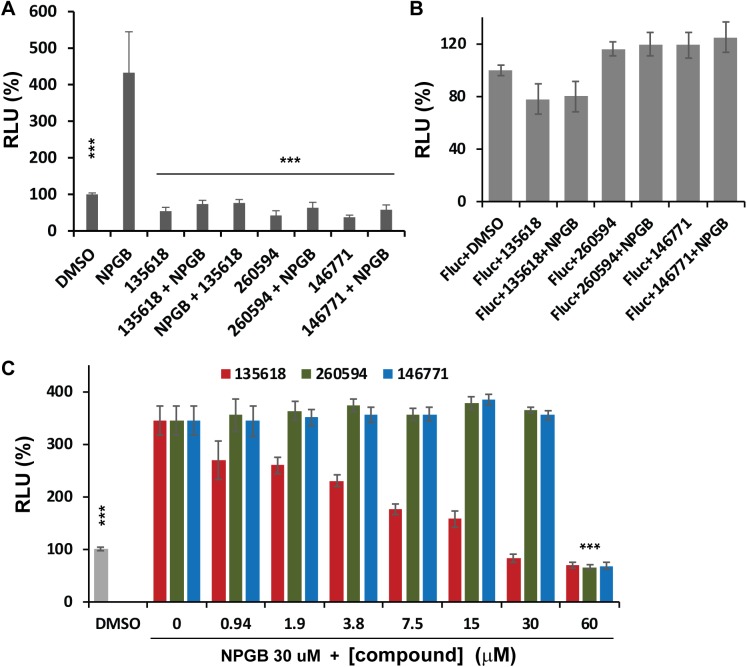
Suppression of NPGB-induced SLC enhancement by candidate allosteric inhibitors.(A) Active-site inhibitor NPGB can induce enhanced SLC which can be suppressed by allosteric inhibitors NSC135618, 260594, and 146771 at high concentration. The N2CN3N was at 150 nM. The compounds were at 40 μM. NSC135618 or NPGB was first incubated with the SLC protease construct for 30 min. in different orders, prior to addition of the luciferin substrate, followed by luminescence detection. N = 3. ***, P < 0.01, by one-way ANOVA. (B) The candidate compounds do not significantly affect the luciferase activity of FLuc (150 nM). The experimental procedure was the same as above. (C) Inhibition of the NPGB-induced SLC enhancement by a concentration series of candidate inhibitors, as indicated. In all panels, DMSO only control was set as 100% relative luminescence (RLU). Luciferase activities of the N2CN3N protease construct with NPGB and/or various compounds were set as percentage of the DMSO control. N = 3. ***, P < 0.01, by one-way ANOVA.